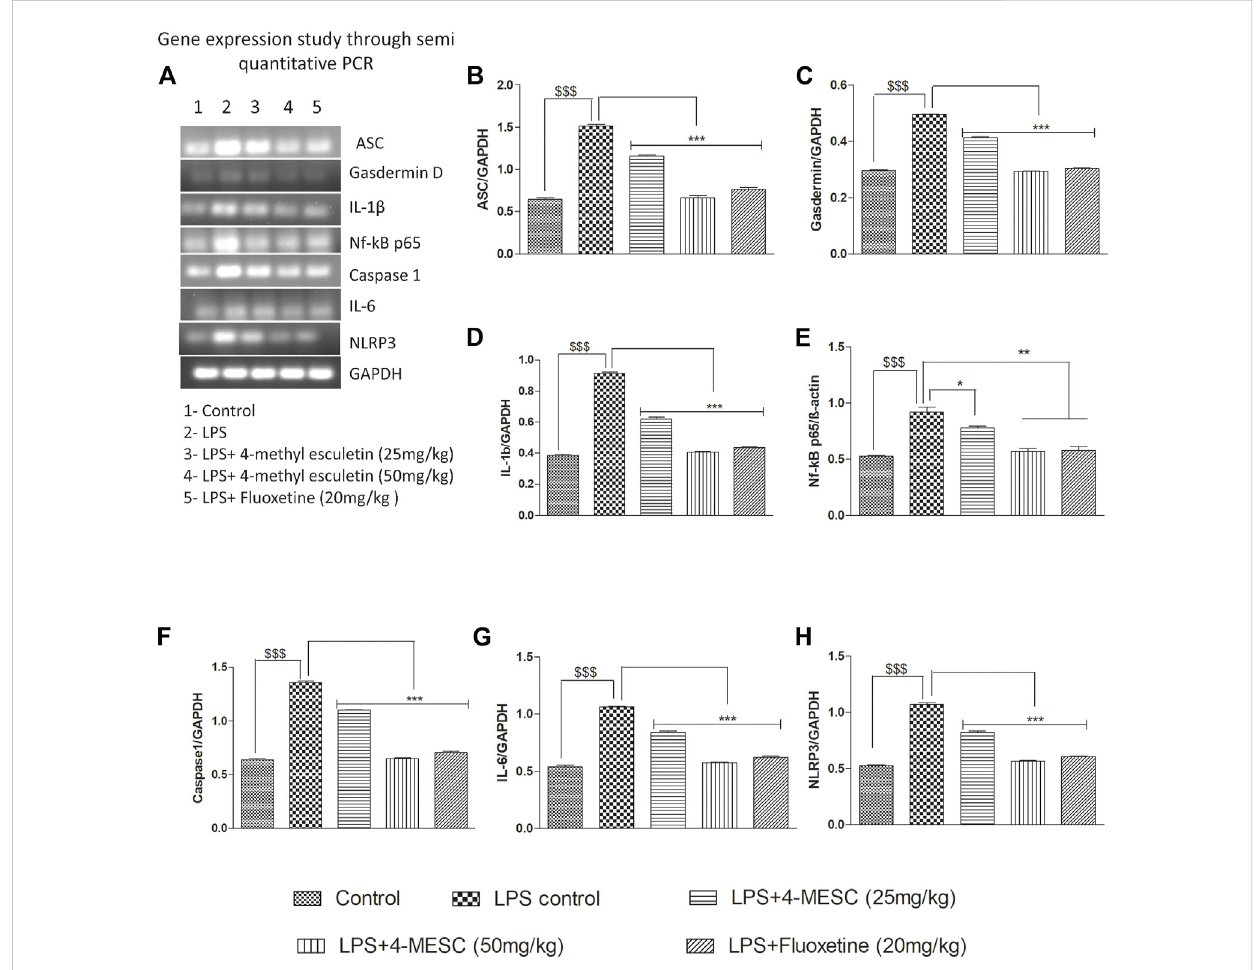
Effect of 4-MESC on gene expression involved in the NLRP3 in fl ammasome pathway evaluated through semi-quantitative PCR. (A) Representative agarose gel image of different genes, where lane 1, 2, 3, 4, and 5 represent the control, LPS, LPS +25 mg/kg of 4-MESC, LPS +50 mg/kg of MESC, and LPS+20 mg/kg of the fl uoxetine group, respectively. (B) ASC, (C) caspase-1, (D) gasdermin D, (E) IL-1b, (F) NLRP3, (G) IL-6, and (H) Nf- κ